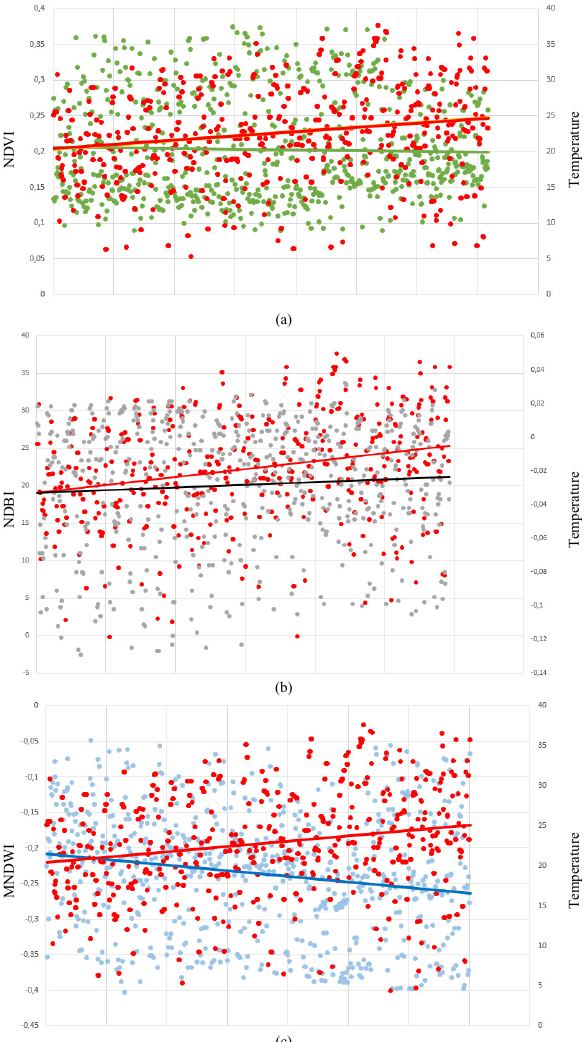
Figure 5. Statistical visualization of mean values acquired based on Landsat imagery during the 30 years for the city of Mexico City. (a) Relationship between temperature and NDVI, (b) the relationship between temperature and NDBI and (c) the relationship between temperature and